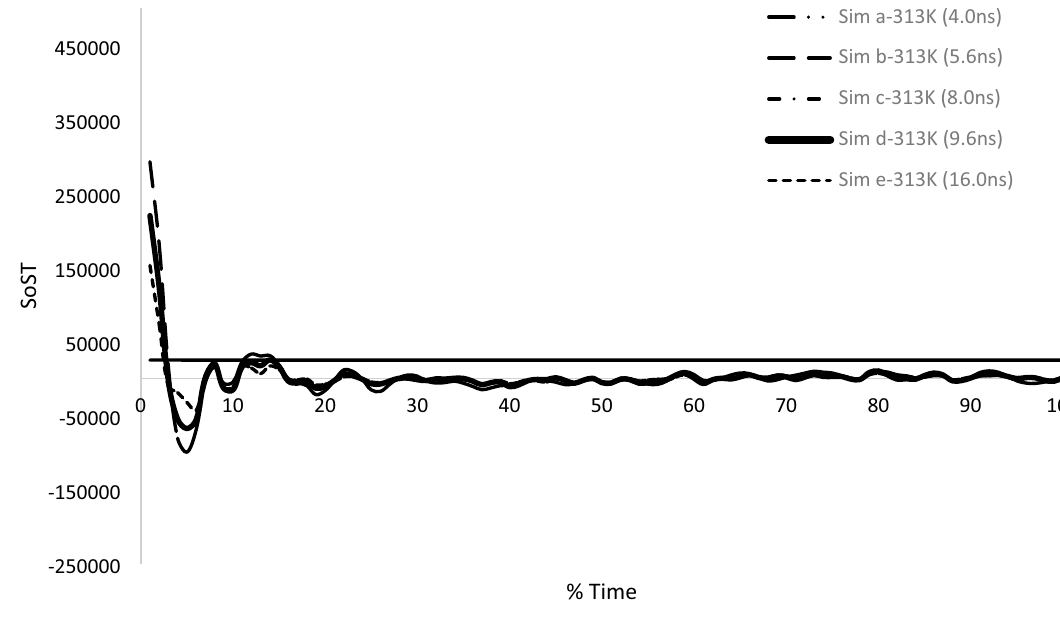
Figure 14. Stress autocorrelation function of different simulation performed at 313 K for BA-CuO H2O nanofluid.